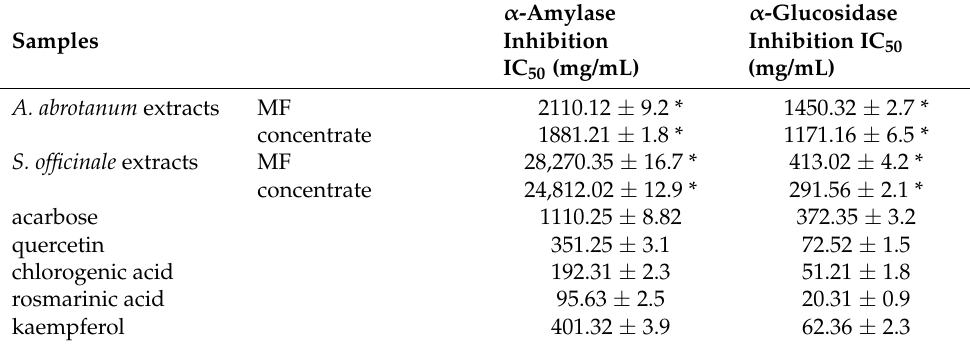
Table 4. The inhibition activity of α -amylase and α -glucosidase of analyzed extracts.